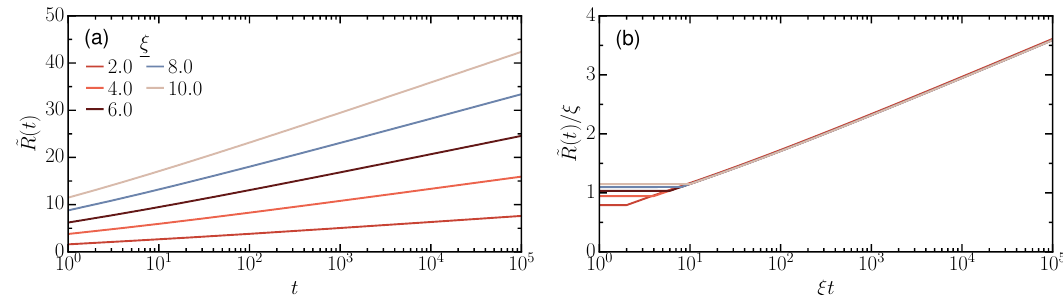
Figure 4: Logarithmic RMS displacement ˜ R ( t ) as a function of time corresponding to the analytical picture. (a) For various localization lengths ξ and L = 1000. (b) The same as (a), but ˜ R ( t ) /ξ plotted vs ξ t